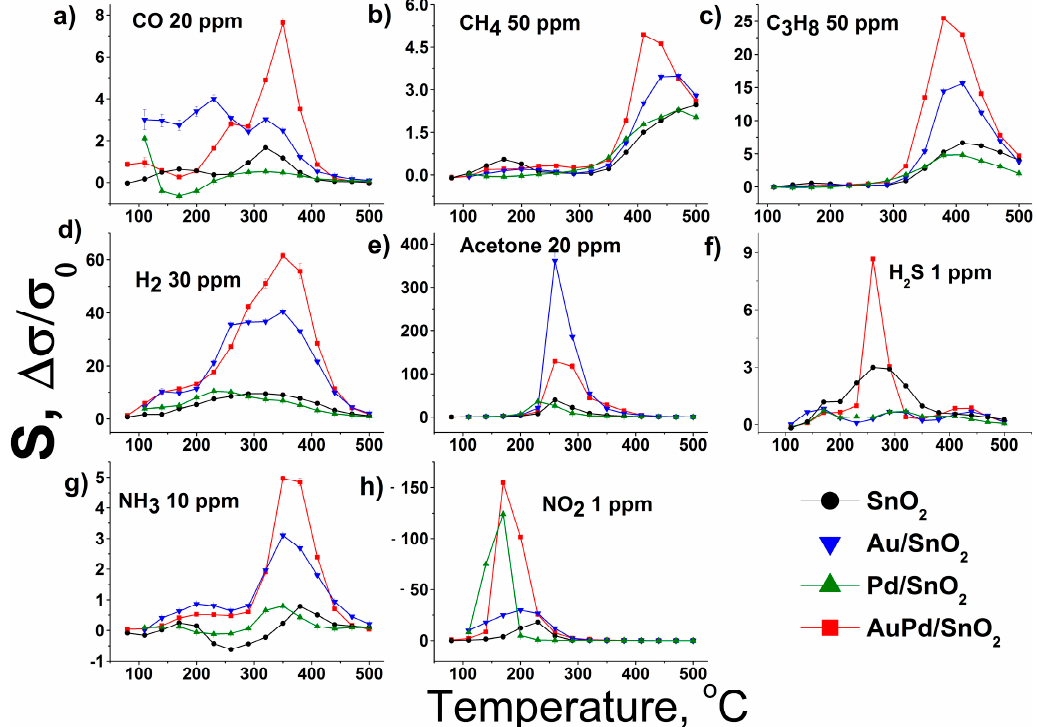
Figure 4. Dependence of gas sensor response of synthesized materials on sensor working temperature towards ( a ) CO 20 ppm, ( b ) CH 4 50 ppm, ( c ) C 3 H 8 50 ppm, ( d ) H 2 30 ppm, ( e ) acetone ppm, ( f ) H 2 S 1 ppm, ( g ) NH 3 10 ppm, ( h ) NH 3 10 ppm in dry